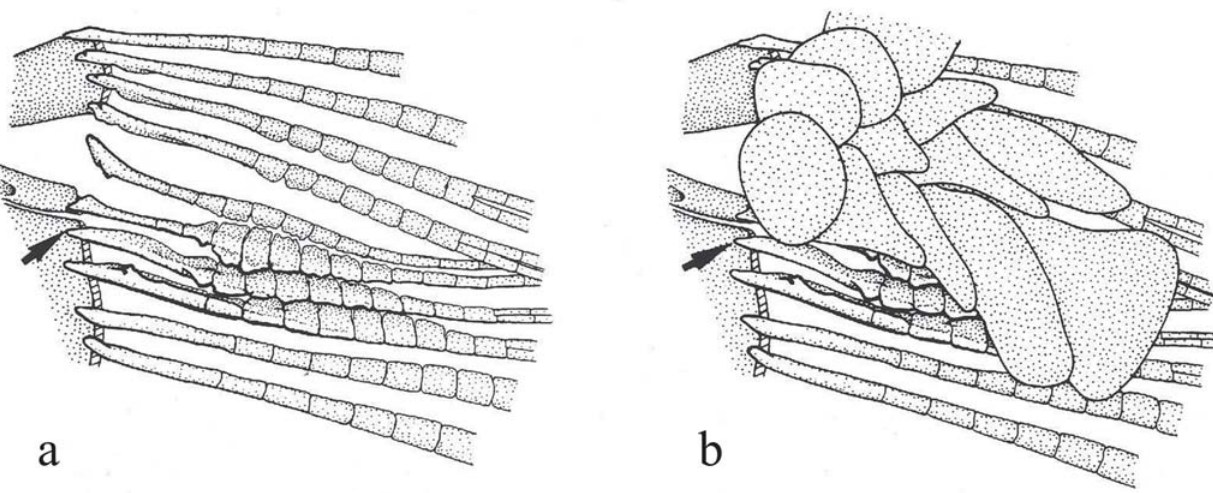
Fig. 38. Mimagoniates barberi , adult male, UMMZ 205420, 35.6 mm SL; osteology of central basal region of caudal skeleton, principal caudal-fin rays 6-15, lateral views, left side, anterior is at left. Principal ray 12 indicated by arrow. (a) Illustrates glandular groove between rays 11 and 12. (b) Illustrates relationship of modified dorsal caudal-fin lobe squamation to glandular groove. Modified scales together their epidermis form movable flap just lateral to surface of rays and groove that bear most of glandular tissue. Modified from Menezes & Weitzman